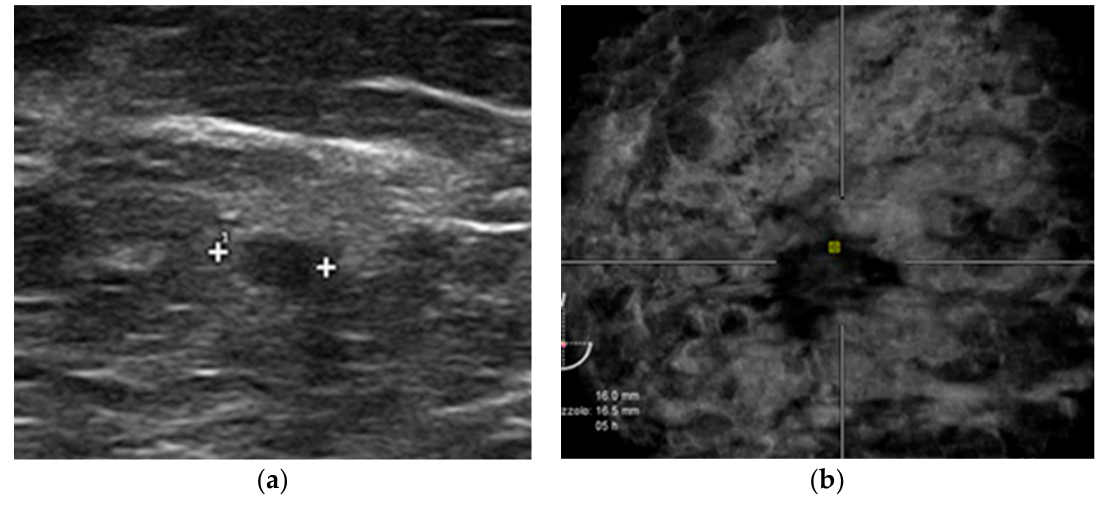
Figure 5. A false-positive case from ABVS caused by nipple artifact. Routine screening for a 67-year-old woman. ( a ) small architectural distortion is seen on ABVS coronal view near the nipple. ( b ) Negative HHUS examination.